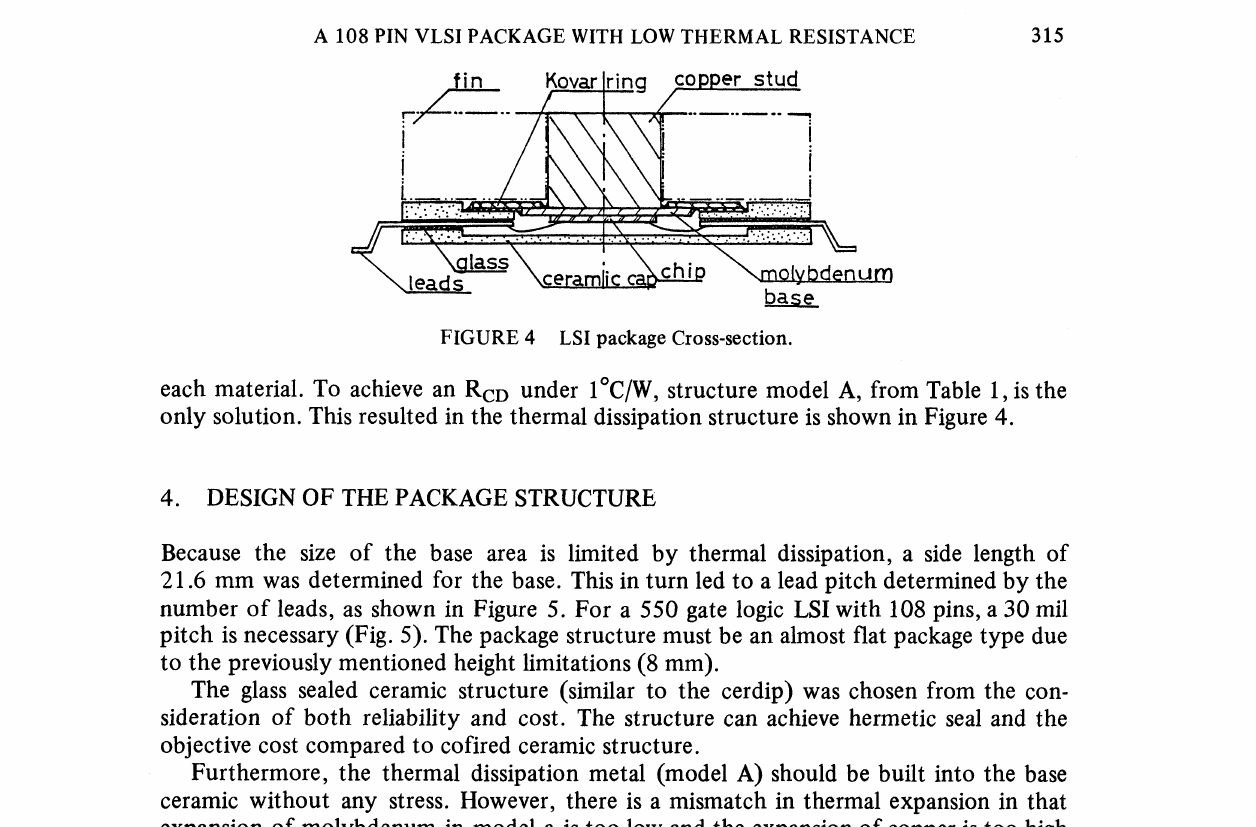
Base size 21.6 x 21,6 mm